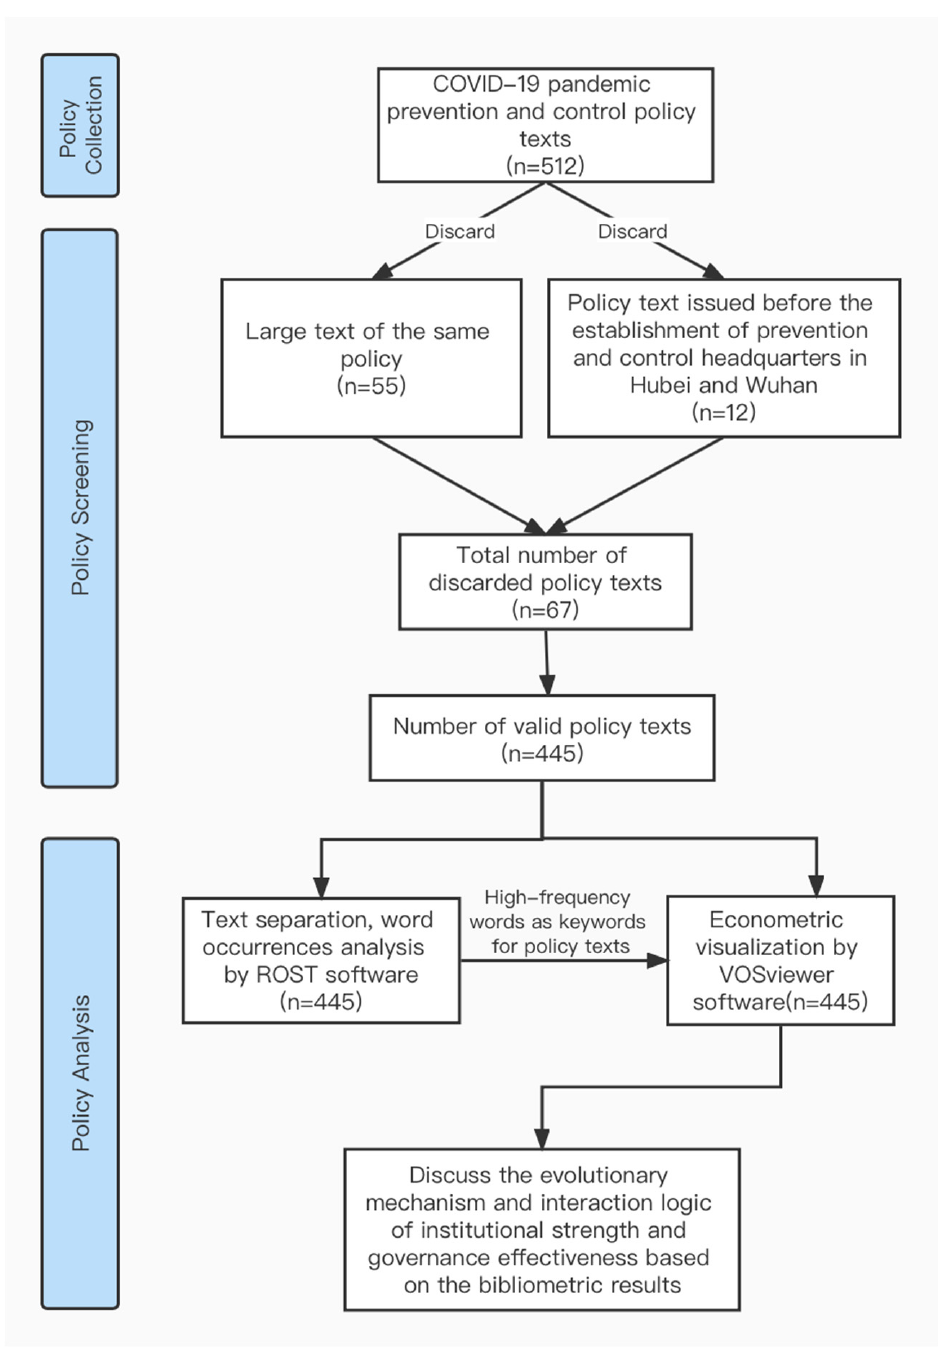
Figure 1. Data processing and research methodology. Source: Authors’ compilation.